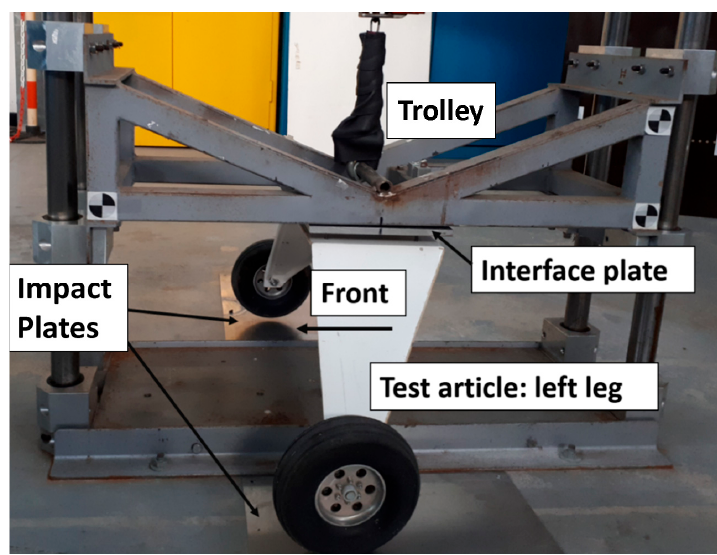
Photonics 2021 , 8 , 450 Figure 3. Small drop tower at the Crash Test Facility, CIRA. Figure 3. Small drop tower at the Crash Test Facility, CIRA.